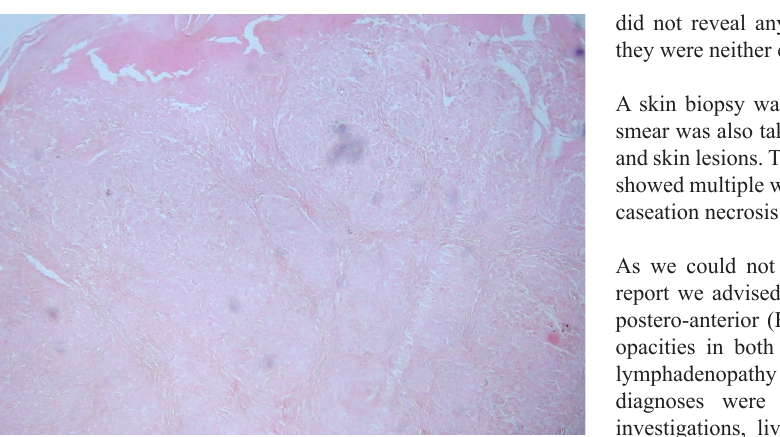
Sarcoidosis Treated as Hansen